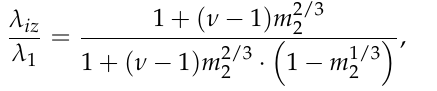
Table 1. Experimental mean values of the apparent density ρ , absolute skeleton density ρ s , water absorption ψ sat , porosity P and thermal conductivity in the dry state λ dry of specimens in four series. ρ , ρ s , Series ψ sat P nr kg/m 3 kg/m 3 1